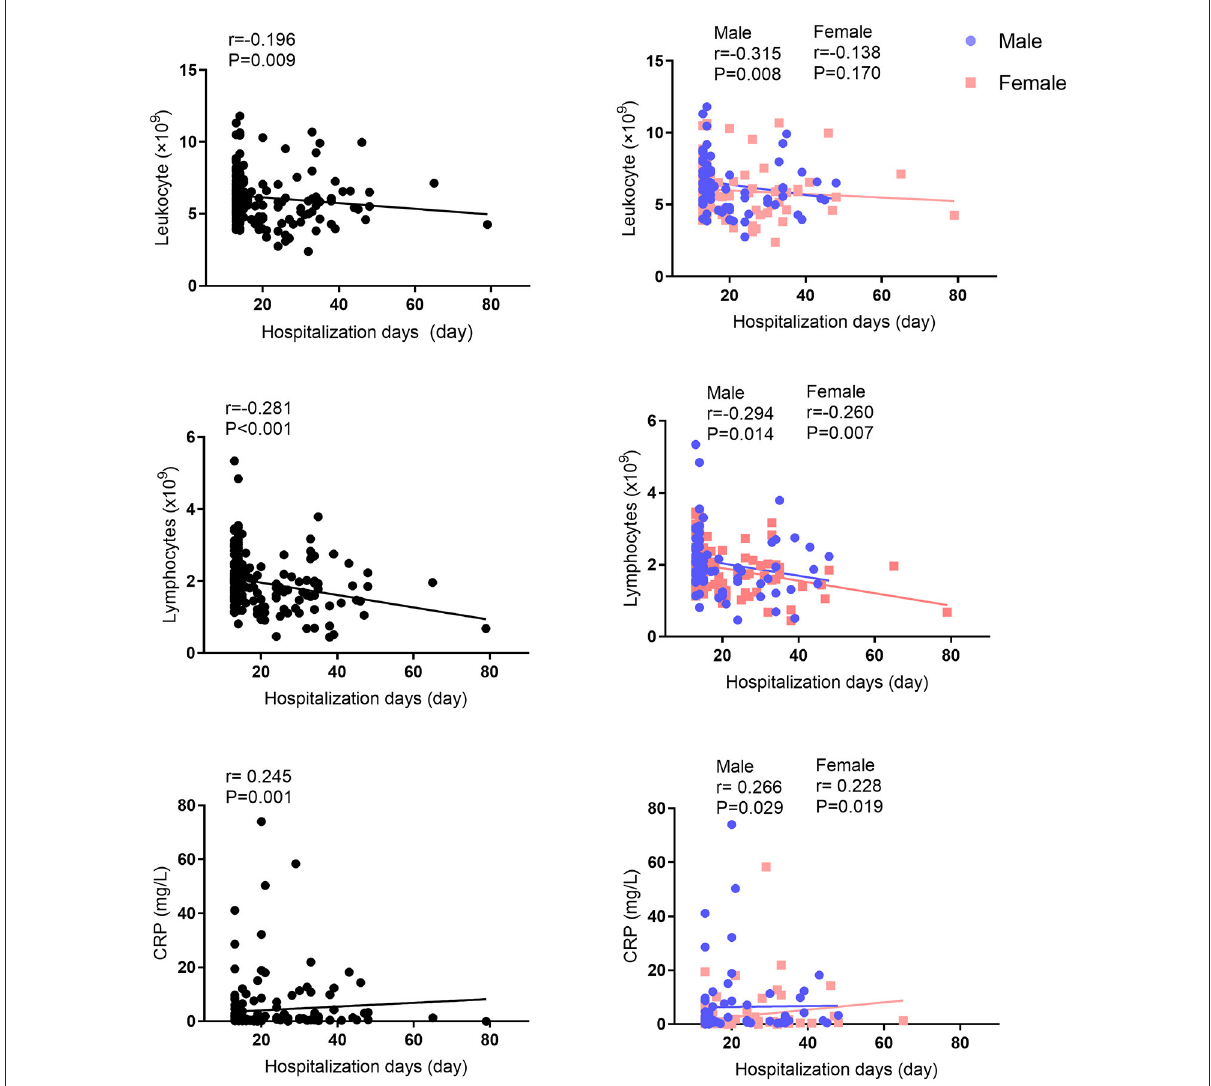
FIGURE3 Correlation analysis between hospitalization days and leukocytes, lymphocytes, or CRP